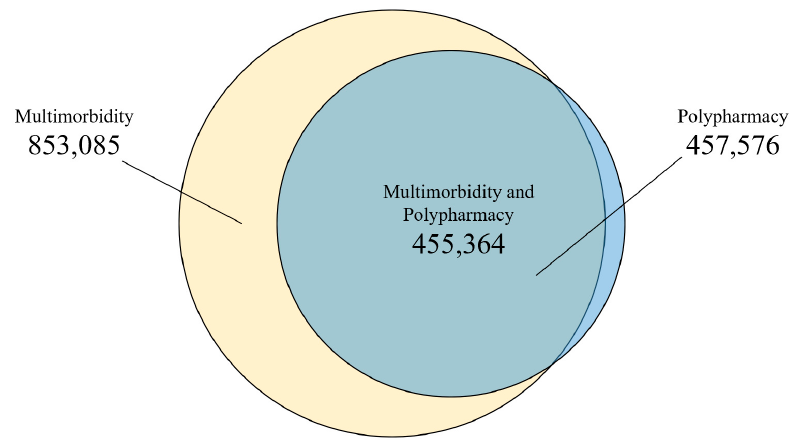
Figure 3. Multimorbid and polymedicated individuals in the study aged 65–99 years ( n = 916,619, Catalonia, 2012).